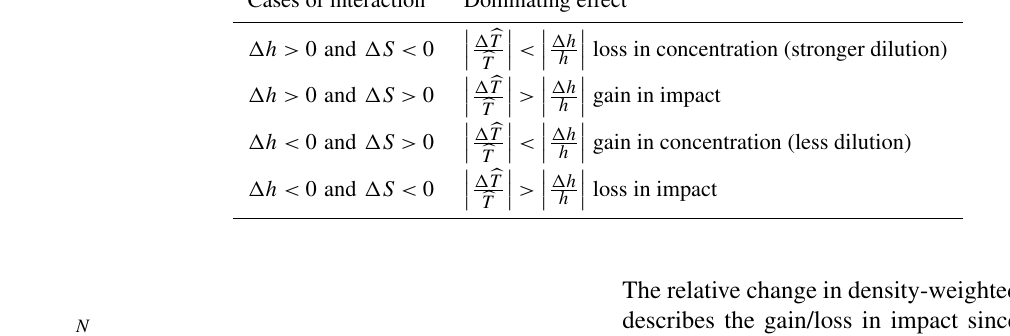
Table 1. Subdivision of the difference in emission sensitivity (cid:49)S caused by FL height variations (cid:49)h assigned to their dominating effects. Cases of